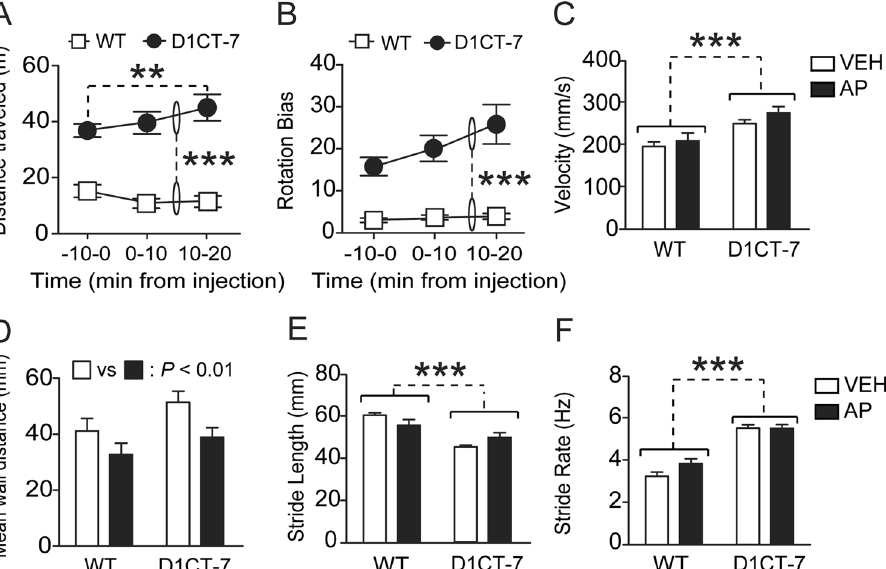
Figure 3. Effects of allopregnanolone (AP; 15 mg/kg, IP) on the locomotor activity of D1CT-7 and wild-type (WT) mice. Data are shown as means ± SEM. ** P < 0.01 and *** P < 0.001 for comparisons indicated by dashed lines. Main effects for genotype are indicated as comparisons between brackets. Doses are indicated in mg/kg (IP). N = 12–13/group. VEH, vehicle. For further details, see text.